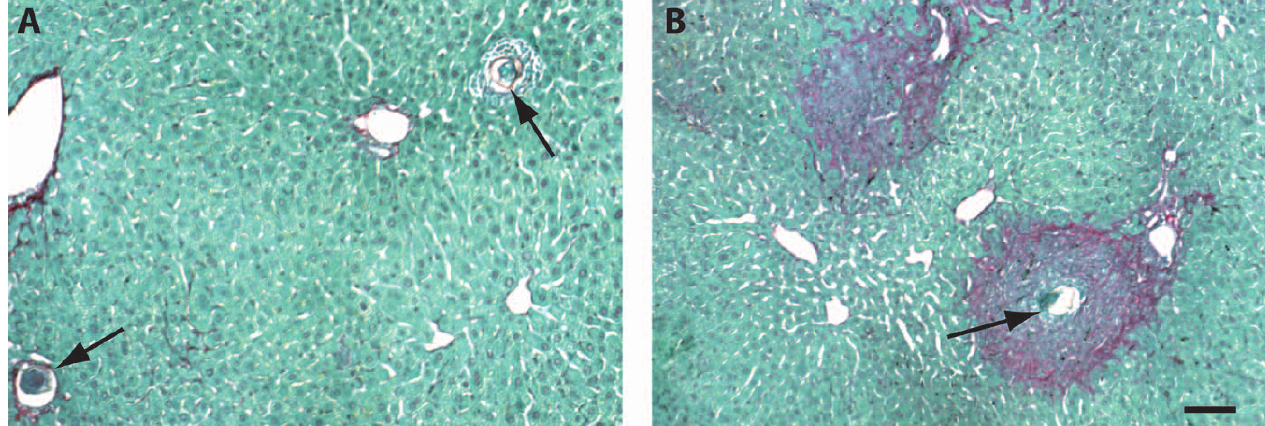
Figure 9. Late Treatment of S. mansoni– Infected Mice with K11777 Decreases the Granulomatous Reaction to Parasite Eggs Trapped in the Liver After necropsy of mice from experiments outlined in Figure 1, livers were sectioned at 5 l m and stained with hematoxylin and eosin. Arrows in representative sections indicate schistosome eggs; the granulomatous reaction to the eggs is much reduced after the late-treatment regimen (A), compared to the intense reaction visible in sections from untreated control mice (B). Note that after early K11777 treatment, eggs or egg-associated granulomas were not found (unpublished data). Scale bar ¼ 100 l